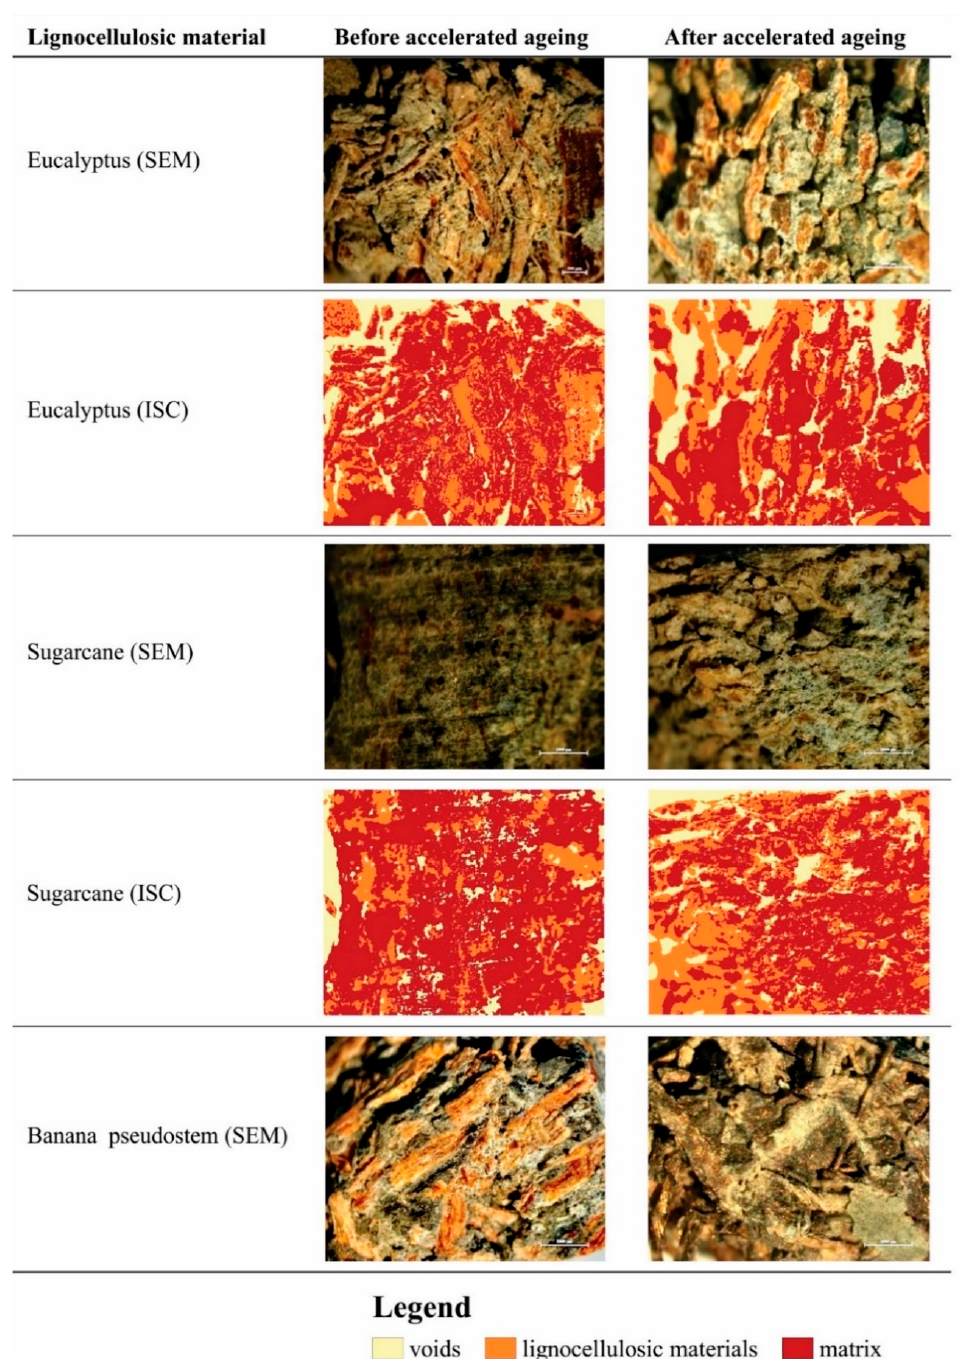
Figure 2. Scanning electron microscopy (SEM) images and image supervised classification (ISC) of the evaluated lignocellulosic materials before and after the accelerated ageing process.